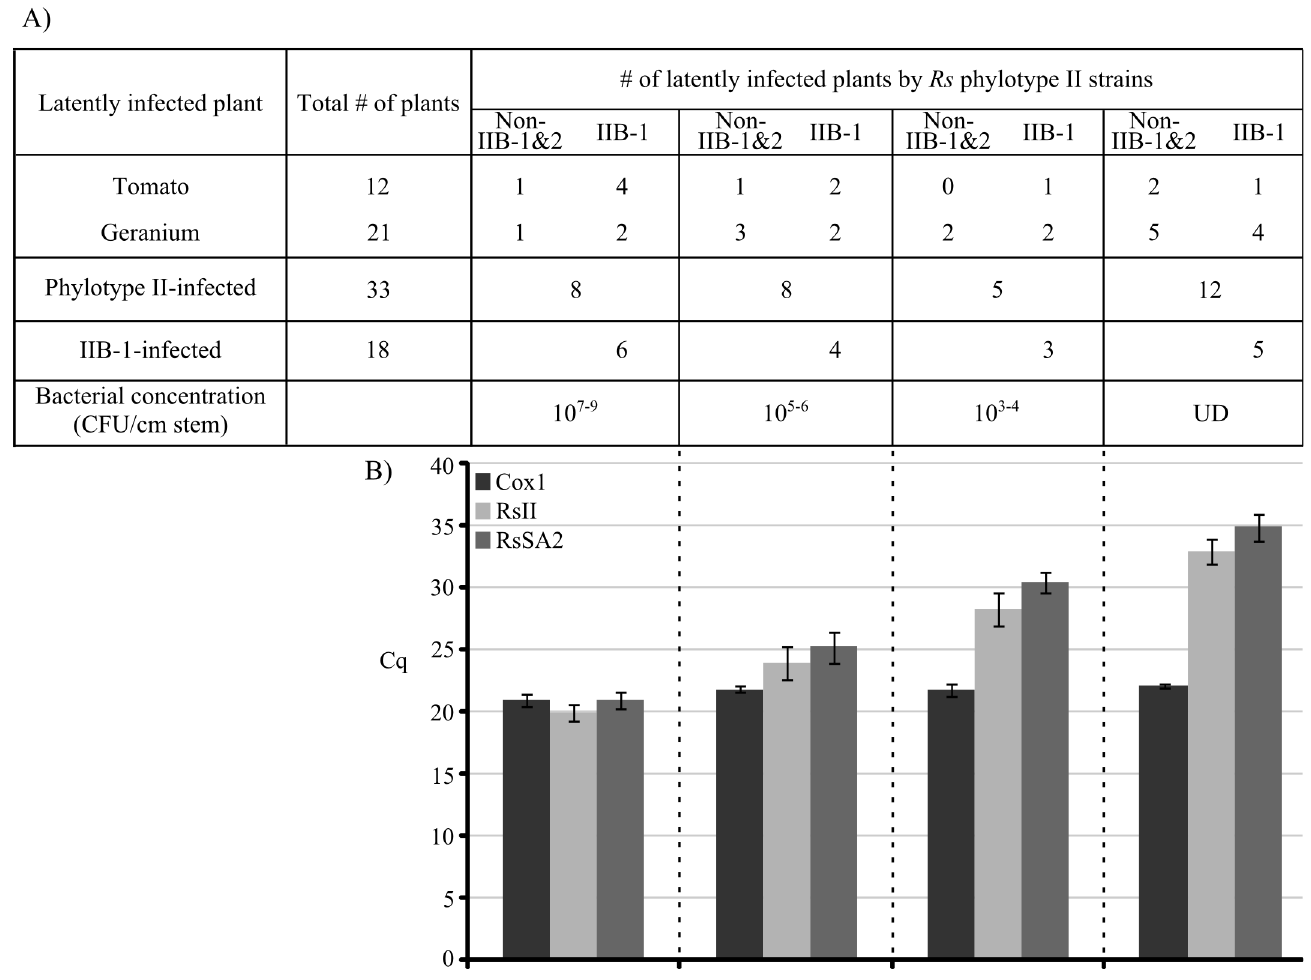
Fig 2. Test of latently infected plants by phylotype II IIB-1 or non-IIB-1&2 strains of Ralstonia solanacearum by dilution plating (A) and qPCR (B). Every sample had a positive Cox1 signal and the mean Cq was 21.72 ( ± 0.17, n = 33). Asymptomatic plants with 10 7 − 9 , 10 5 − 6 , and 10 3 − 4 CFU/ml/cm of Rs had a mean Cq of 19.91 ( ± 0.68, n = 8), 23.97 ( ± 1.27, n = 8), and 28.28 ( ± 1.31, n = 5) for RsII and 20.93 ( ± 0.67, n = 6), 25.21 ( ± 1.23, n = 4), and 30.42 ( ± 0.8, n = 3) for RsSA2, respectively. Asymptomatic plants with undetectable amounts of Rs (UD) had average Cq values of 32.97 ( ± 0.93, n = 12) for RsII and 34.9 ( ± 1.09, n = 5) for RsSA2. Error bars represent standard